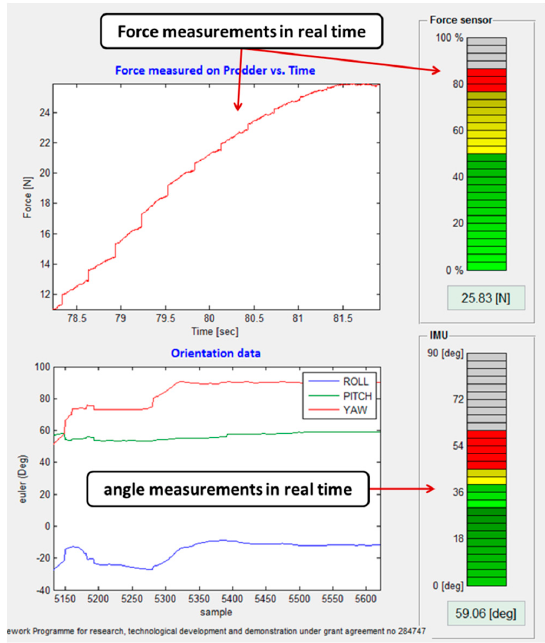
Figure 6. Close-up view of the force and angle data provided by the HMI.